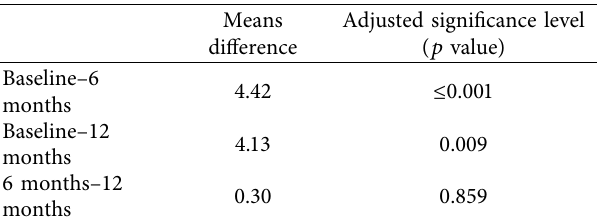
Table 3: Pairwise comparisons in the Friedman